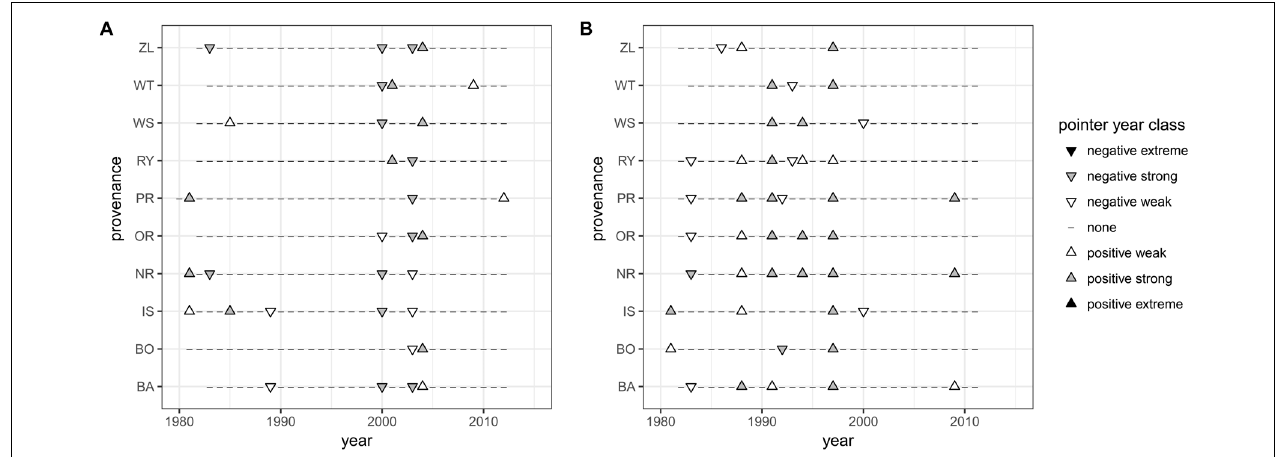
FIGURE 7 | Common pointer years (CPY) for provenances, indicated by upper (positive) and inverted (negative) triangles. Panel A – Knyszyn (KN) site, panel B – Kórnik (KR)